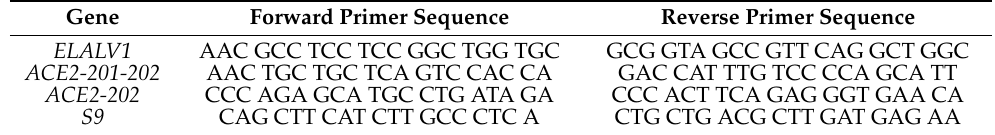
Table 1. Primer sequences used for RT-qPCR